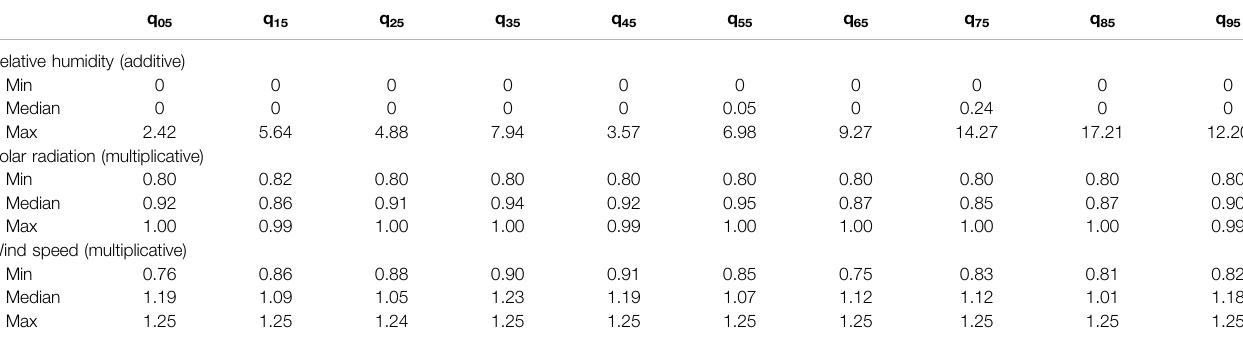
TABLE A2 | Optimized values of WaSIM-ETH free parameters. For the conventional con fi guration, minimal, median and maximal values are obtained from a combination of four reanalyses and four realizations of the optimization process. For the conventional con fi guration, minimal, median and maximal values are obtained from 16 realizations of the optimization process. Threshold temperature for snow/rain transition ( ° C)